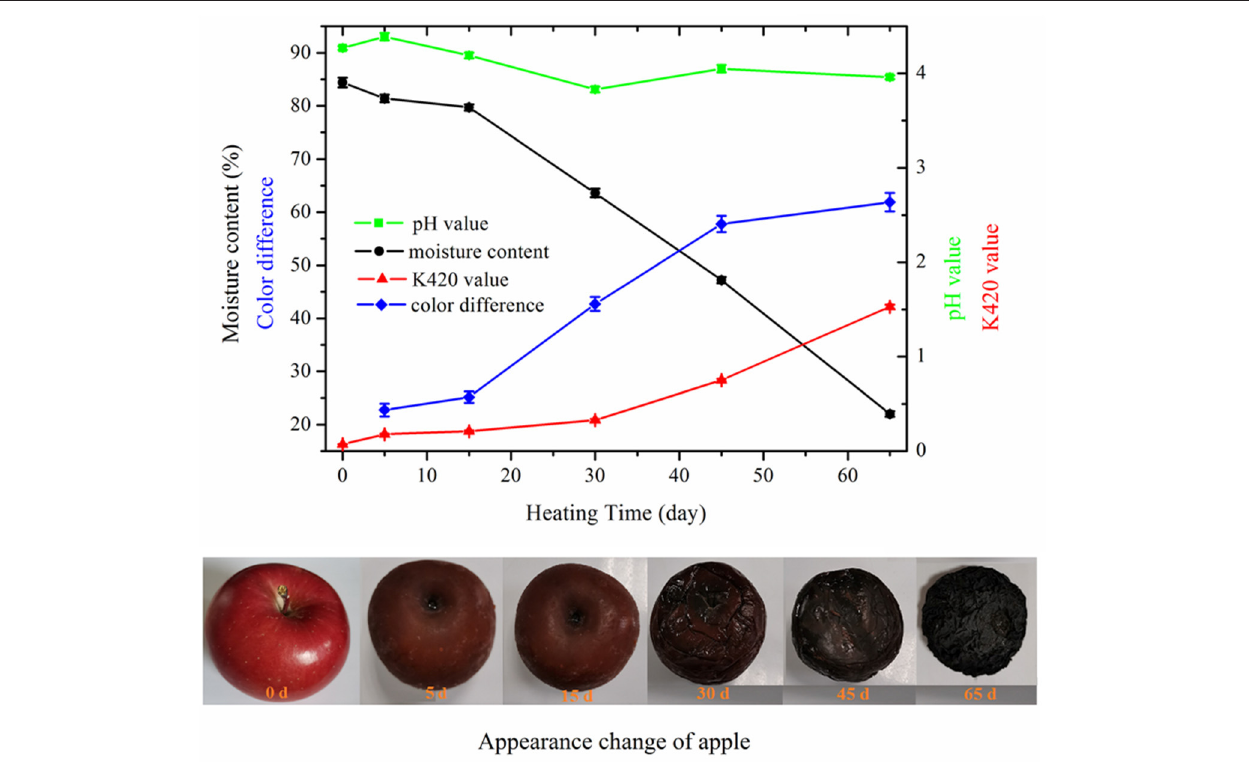
FIGURE 1 | Changes in appearance, moisture content, color difference, browning intensity, and pH of apple during 65-day HTFP process.